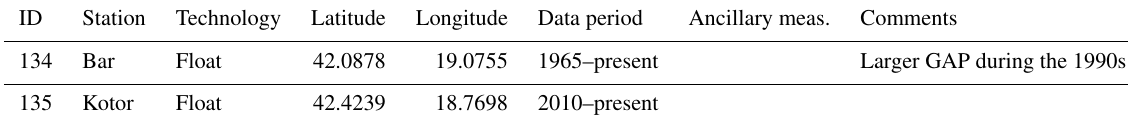
Table A13. National tide gauge network of Montenegro operated by the Institute for Hydrometeorology and